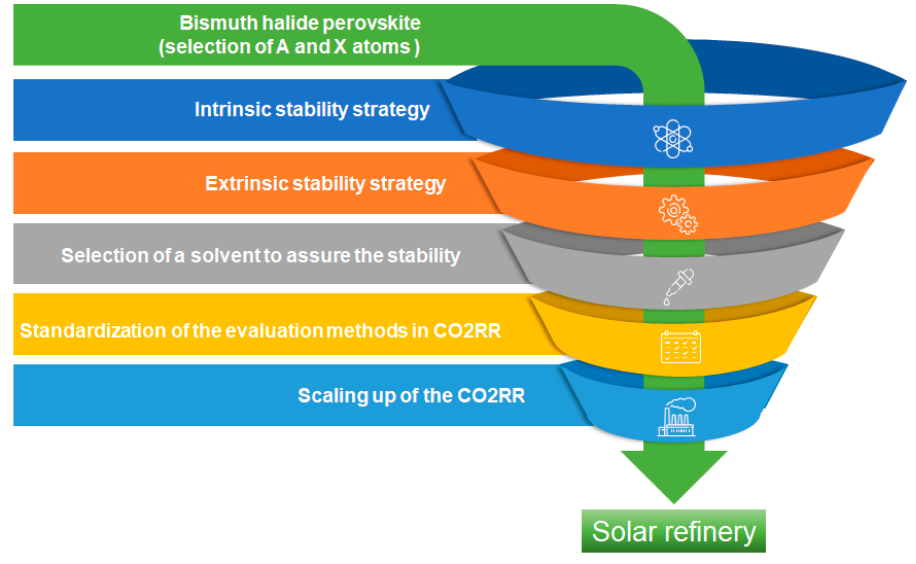
Figure 10. Next steps to design bismuth halide perovskites.